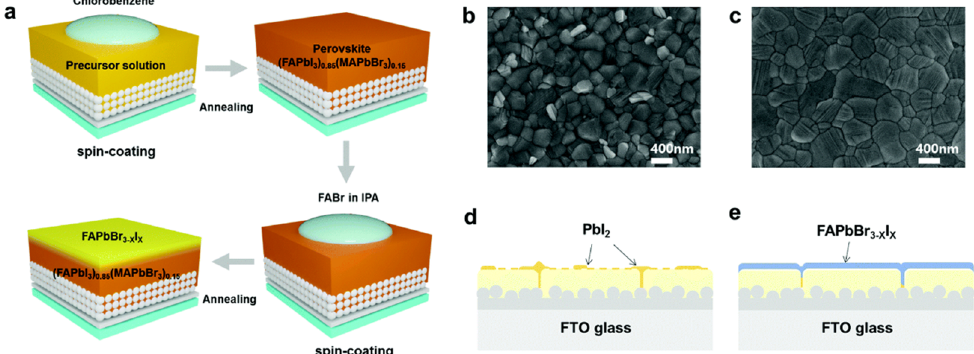
Figure 2. ( a ) Illustration of the fabrication method of FABr passivated perovskite film. Top-view SEM images of ( b ) reference film and ( c ) FABr passivated film. Proposed change of film cross sectional structures of ( d ) reference film and ( e ) FABr passivated film. Republished with permission of Royal Society of Chemistry, from reference [17].